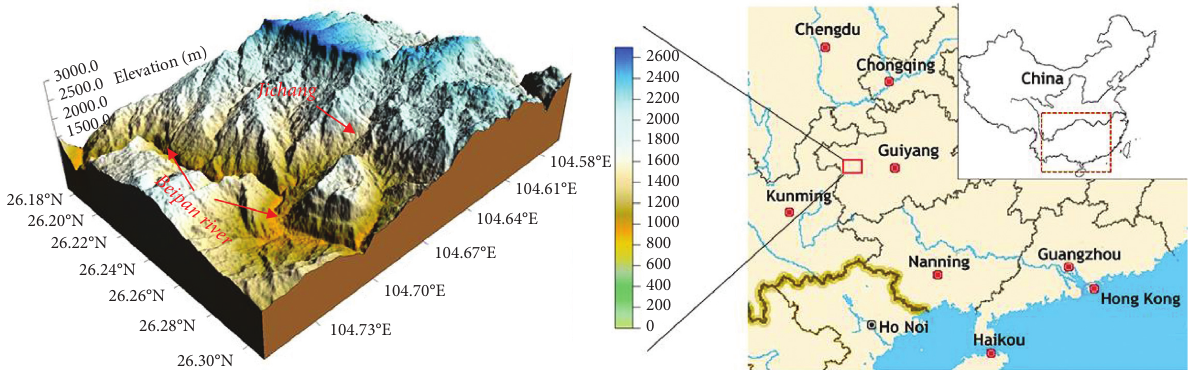
Figure 2: Topographic geomorphologic map of the study area.